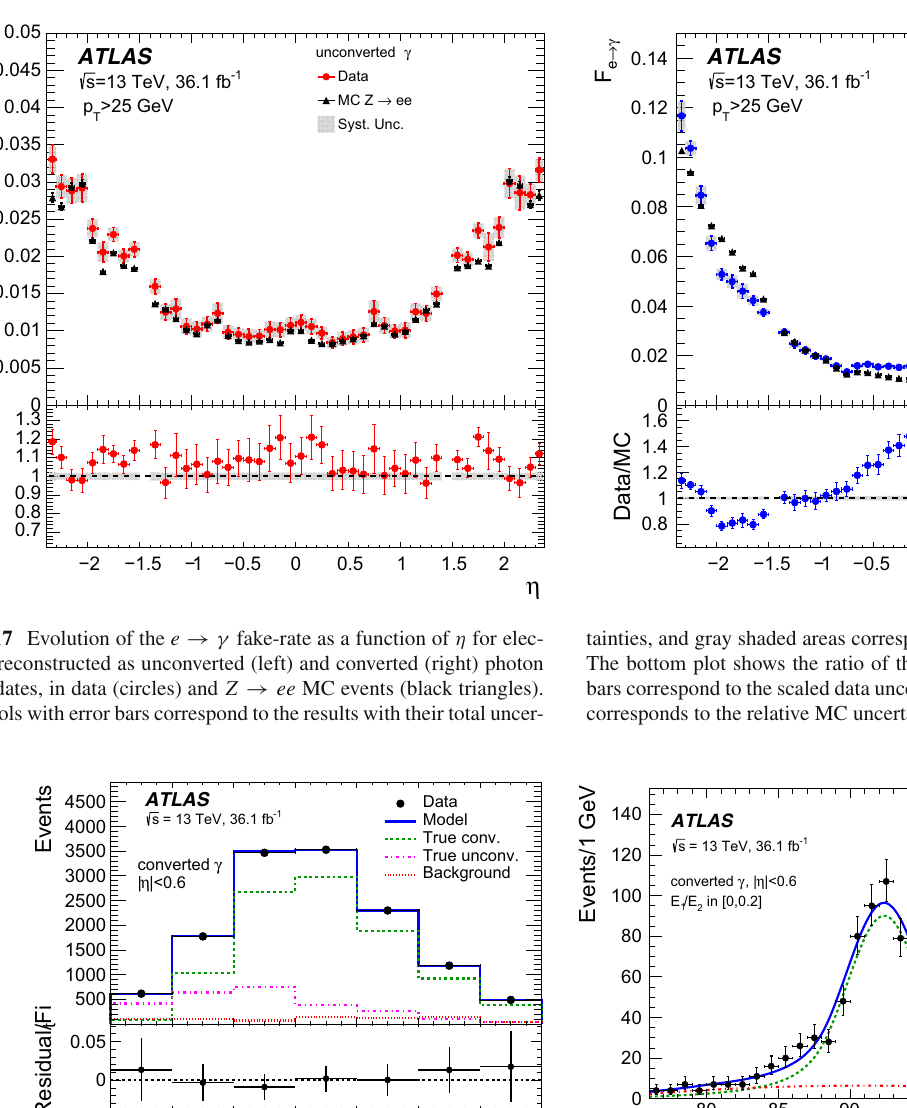
line). Right: Distribution of m μμγ for converted photons with | η | < 0 . 6 in data (black points), together with the model fit to data (blue line) and its signal (dashed green line) and background (dashed red line)